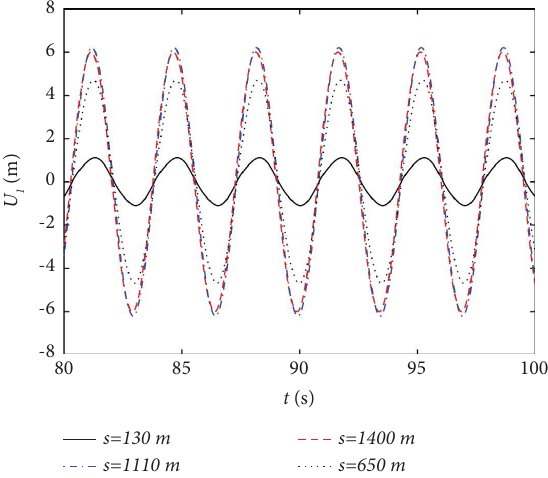
Figure 8: Time history of tangential motion at A